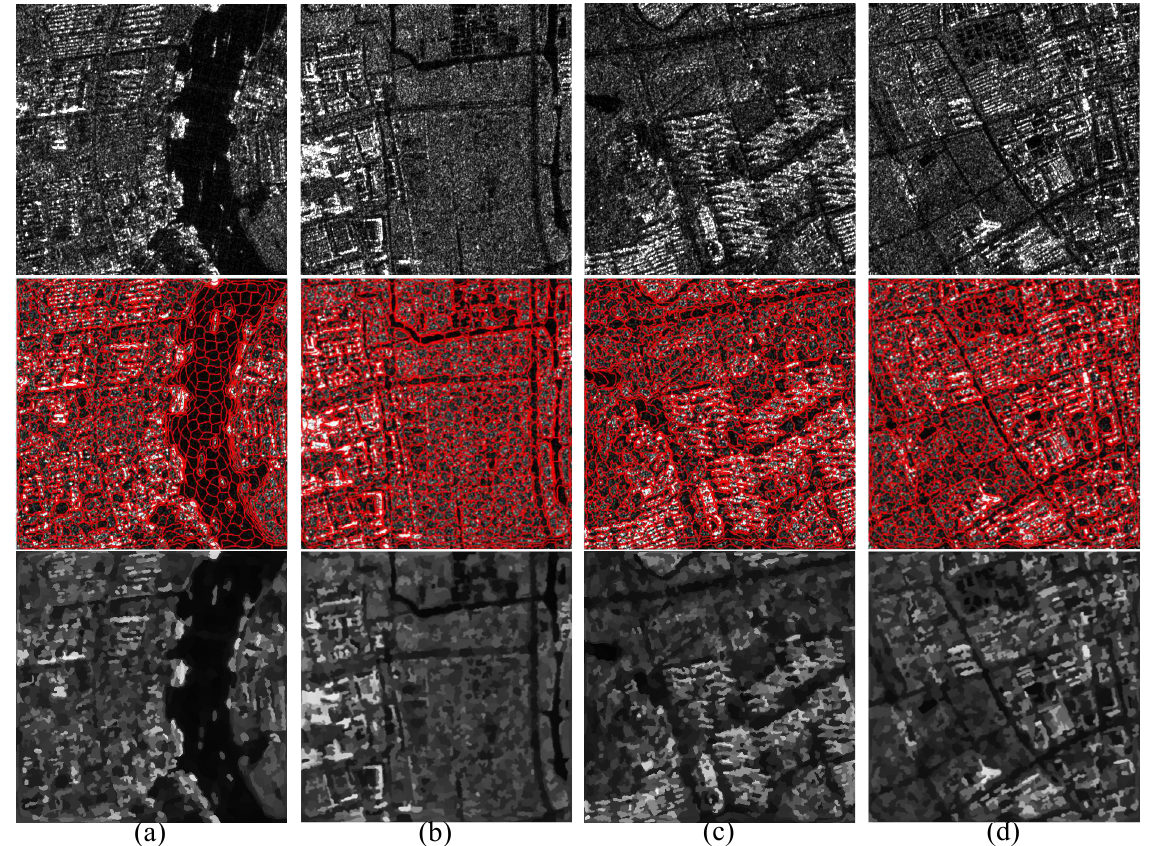
Figure 18. Superpixel generation results of the proposed method for Gaofen-3 SAR images. ( a )